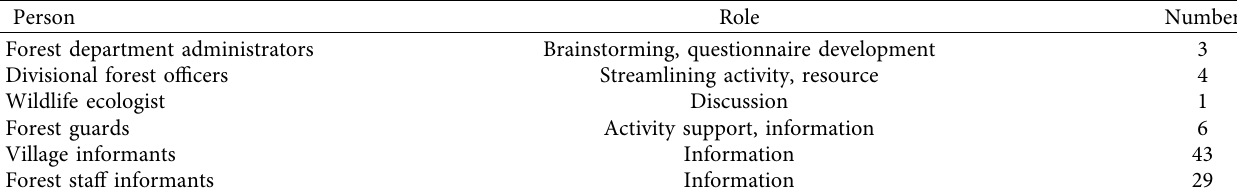
Table 1: Brief details and contribution of diferent stakeholders in the study design.